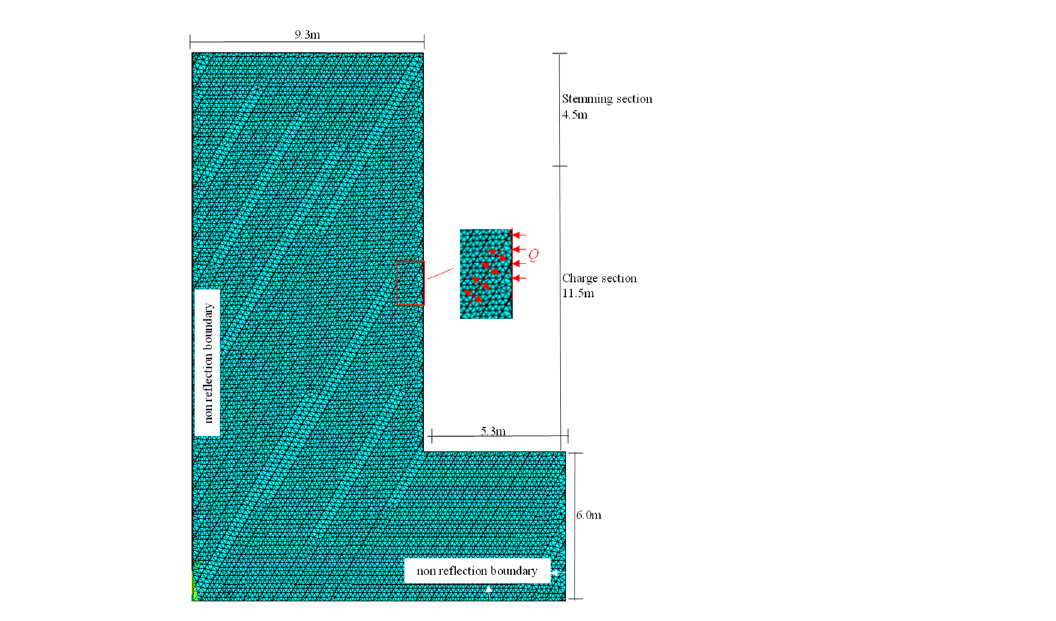
Figure 7. Numerical calculation model of the rock mass behind the borehole under the condition of − 75° rock stratum.